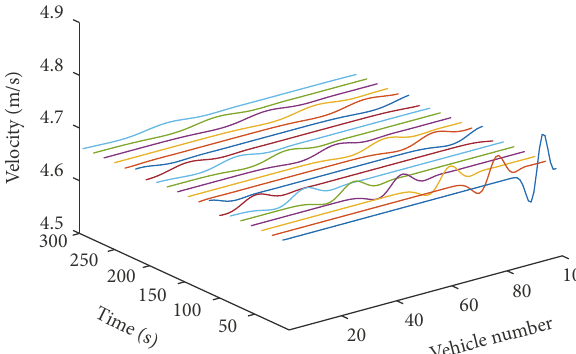
Figure 4: Velocity variation of all vehicles for automated